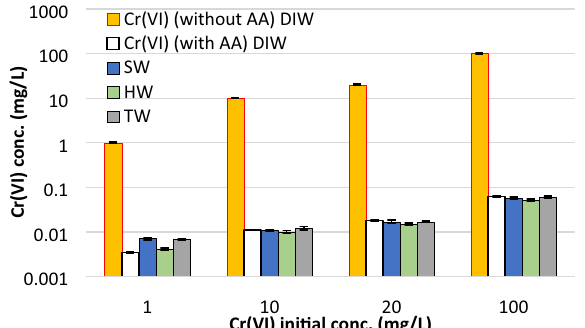
Figure 7. Reduction of Cr(VI) in the presence of optimized concentrations of ascorbic acid in various waters ( DIW deionized water, SW synthetic soft water, HW synthetic hard water, TW real tap water). The reduction was over 99.5% in all waters and the residual concentration of Cr(VI) was below 0.1 mg/L in all